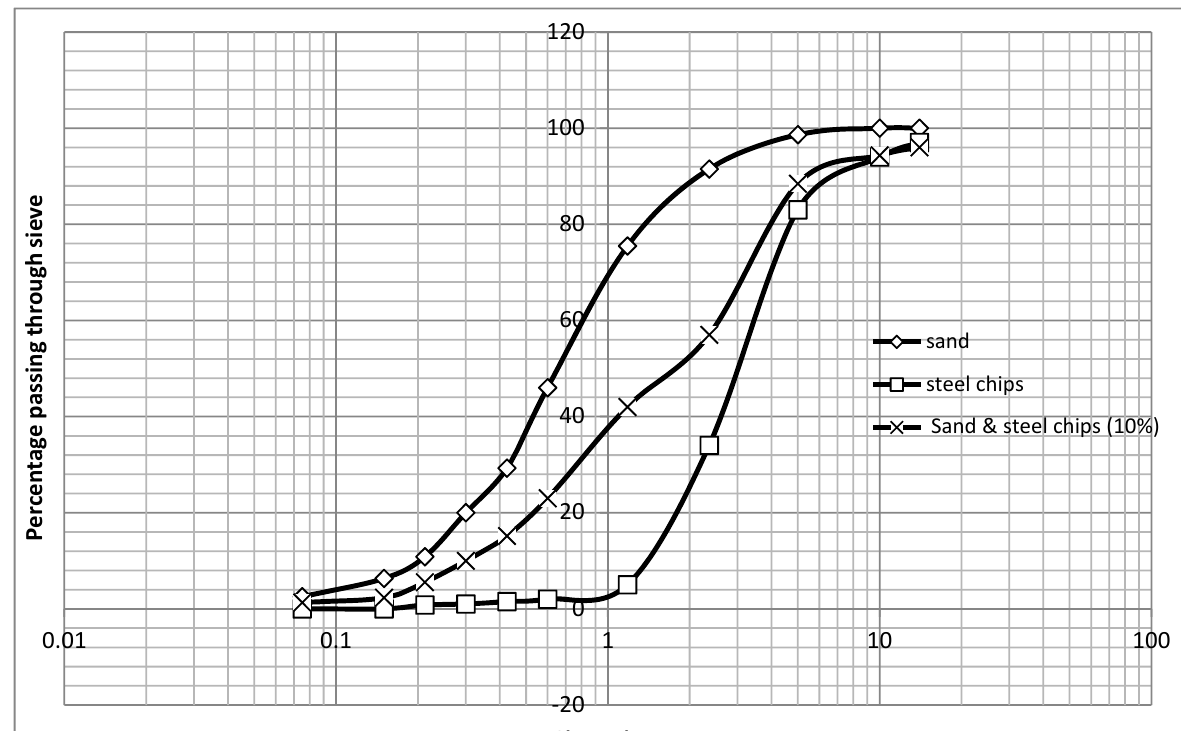
Figure 4. Grading curves for sand and steel chips (10%)